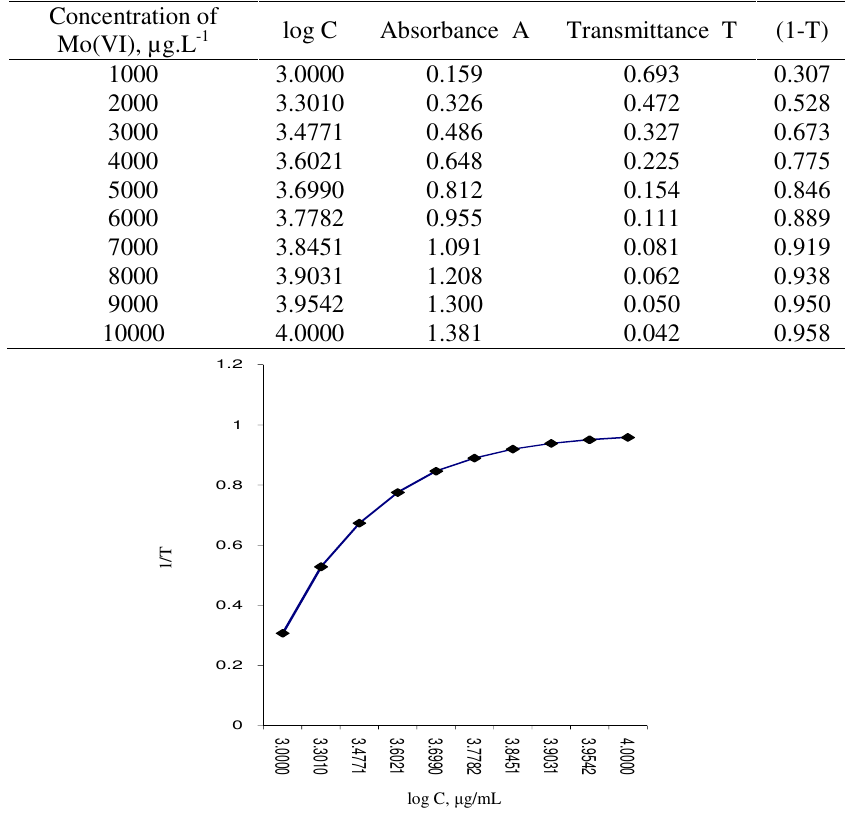
Table 3 . Ringbom plot of Mo(Vi)-GPPH complex